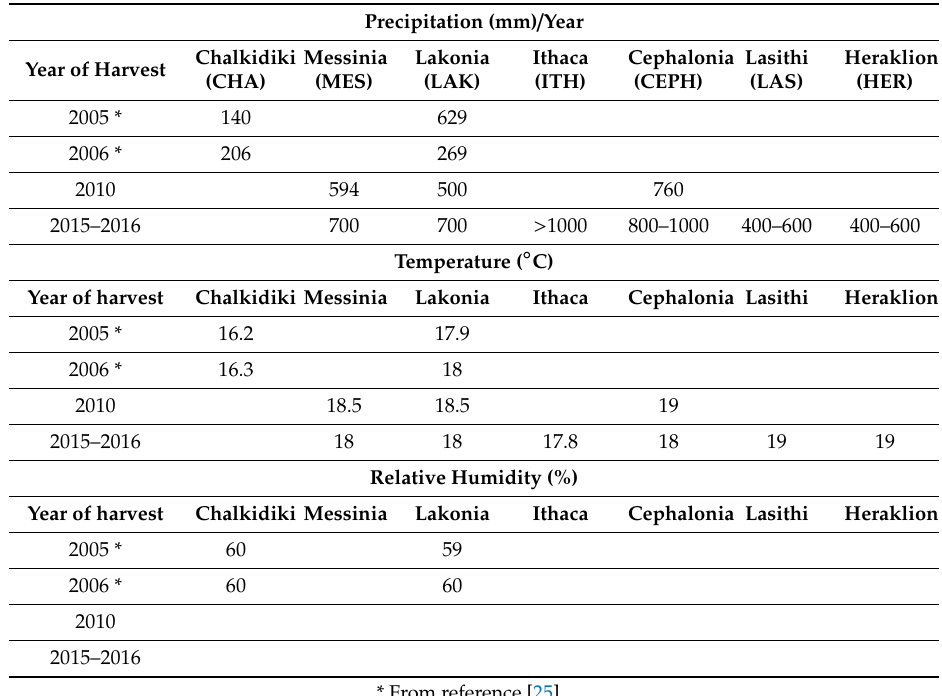
Table 1. The climatic parameters of the olive oil cultivation area in Greece.